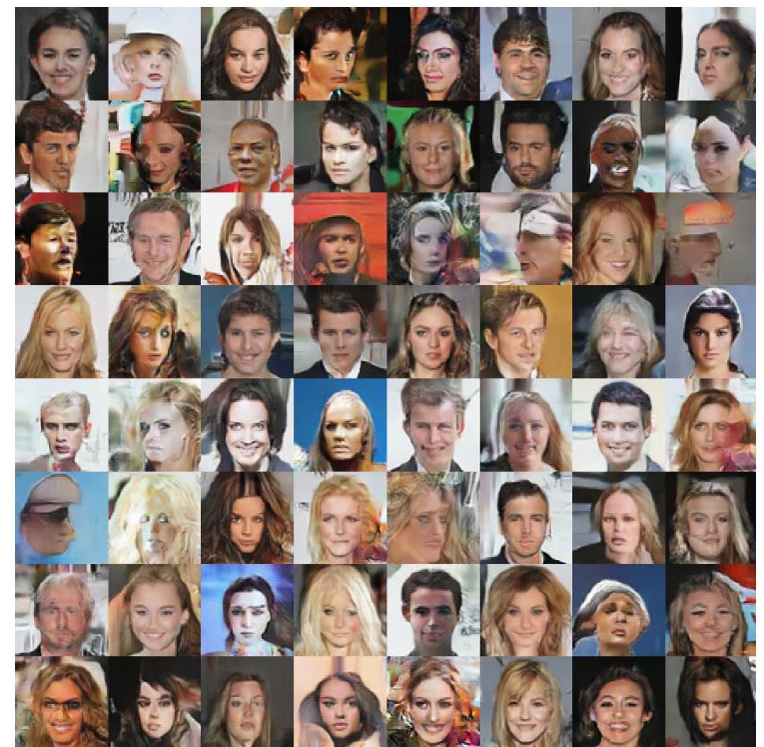
Figure 11. Representative images of CEGAN (Calibrating Energy-based Generative Adversarial Network) [42].